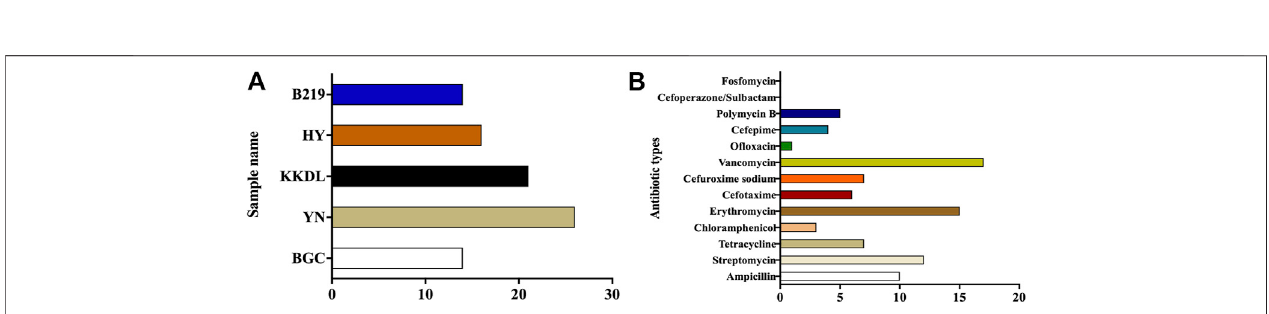
FIGURE 6| Distribution ofARGsin everysampling sites. The ARG classes on the left and the sampling locations on the right side are presented as colored bands. Bar lengths on the outer ring represent the percentage of ARGs in each sample. The inner layer numbers indicate the relative abundances of ARG classes from a given sample (left) and the relative abundance of speci fi c ARG classes in samples